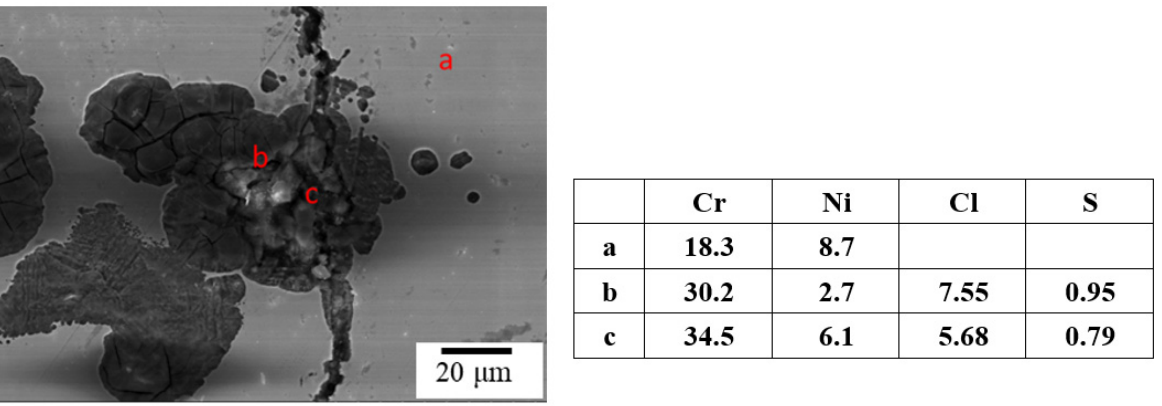
Figure 11. The inclusions in the cracks were examined by the EDX technique.